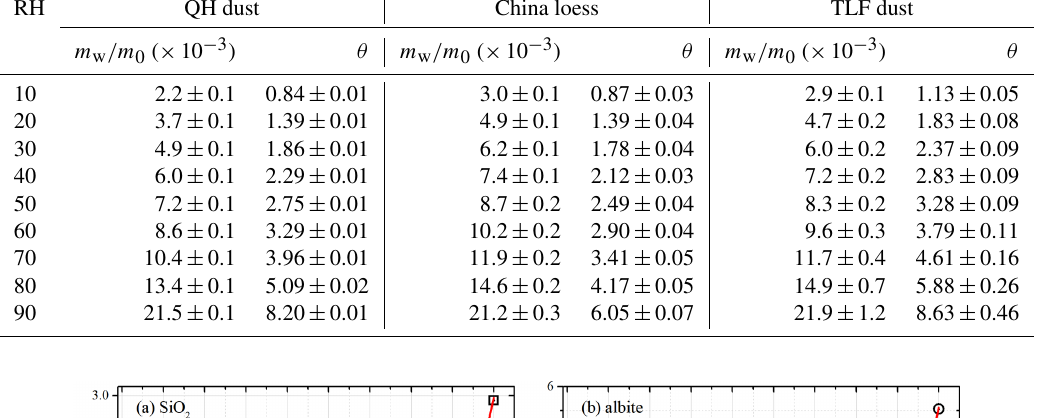
Table 5. Mass ratios of adsorbed water to the dry mineral ( m w /m 0 ) and surface coverages of adsorbed water ( θ ) as a function of RH (%) for QH dust, China loess and TLF dust.